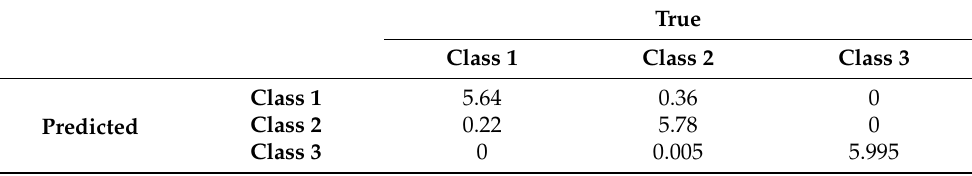
Table 6. Mean confusion matrix for Logistic Regression classifier with linear kernel.